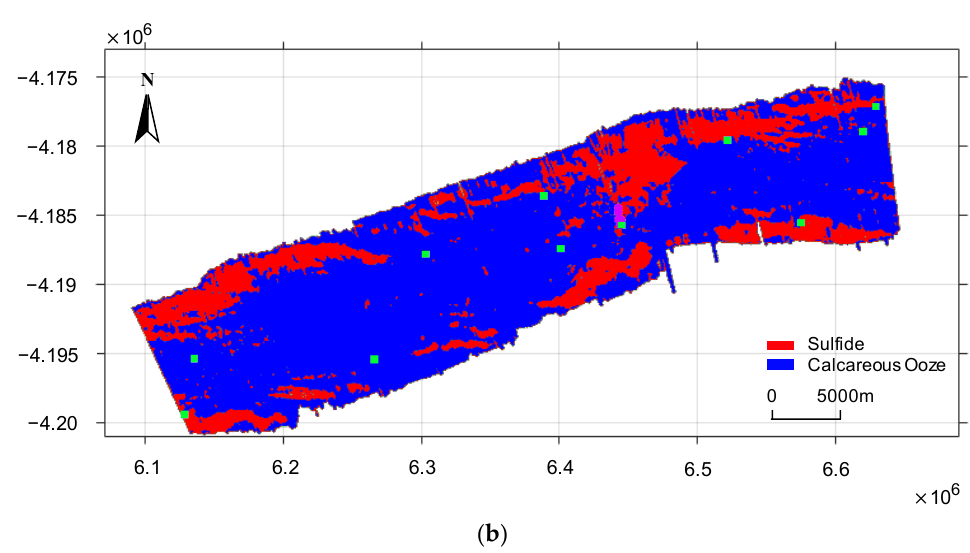
Figure 9. Results of seabed sediment classification by supervised SVM and GA–SVM: ( a ) seabed sediment classification results using SVM; and ( b ) seabed sediment classification results using GA–SVM.